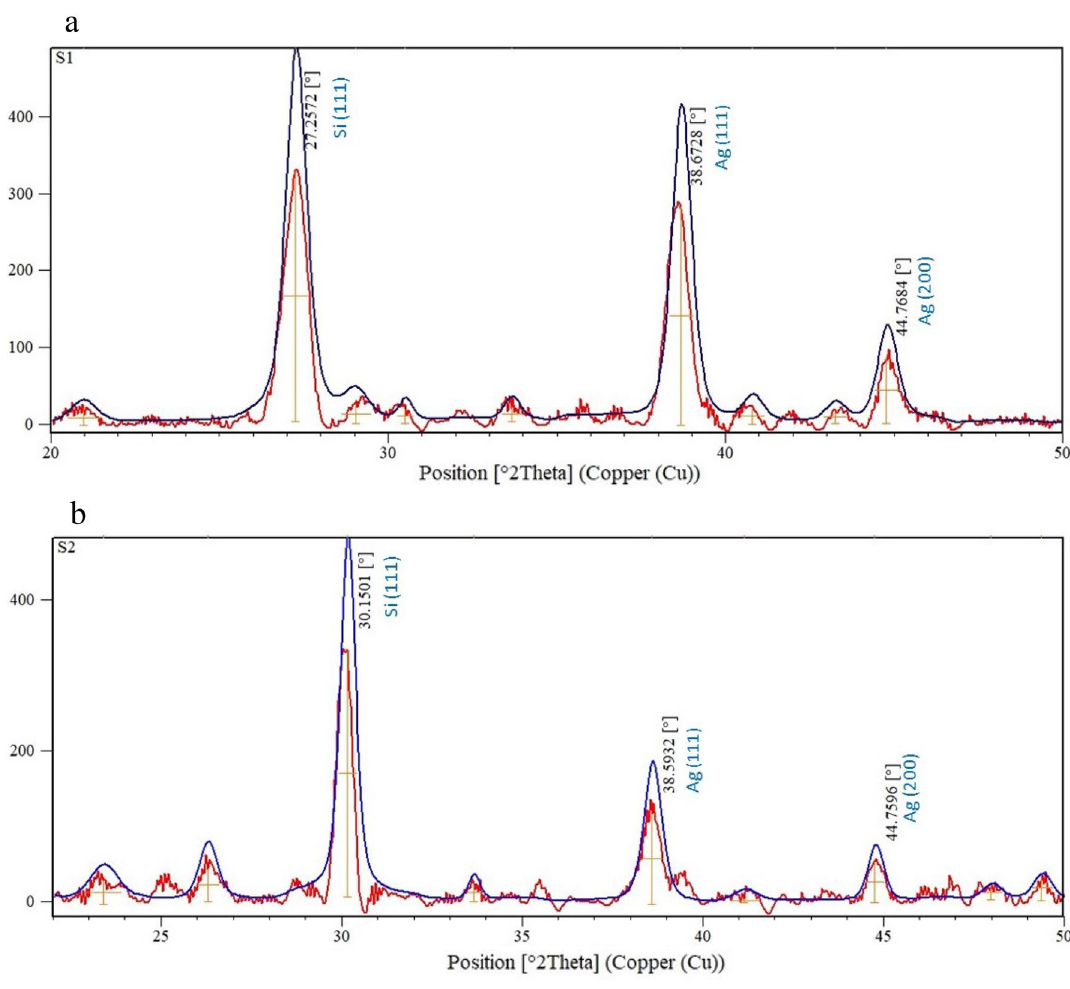
Figure 3. XRD diffraction of the monolayer and bilayer different dimensional of Ag NPs.